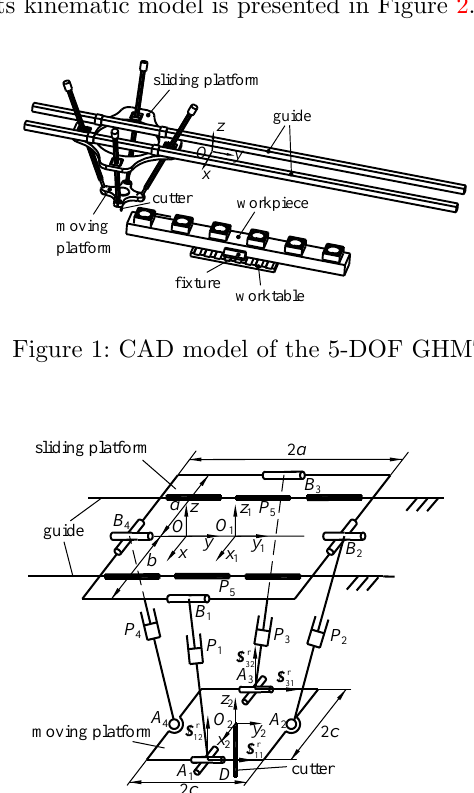
Figure 2: The schematic diagram of the 5-DOF GHMT